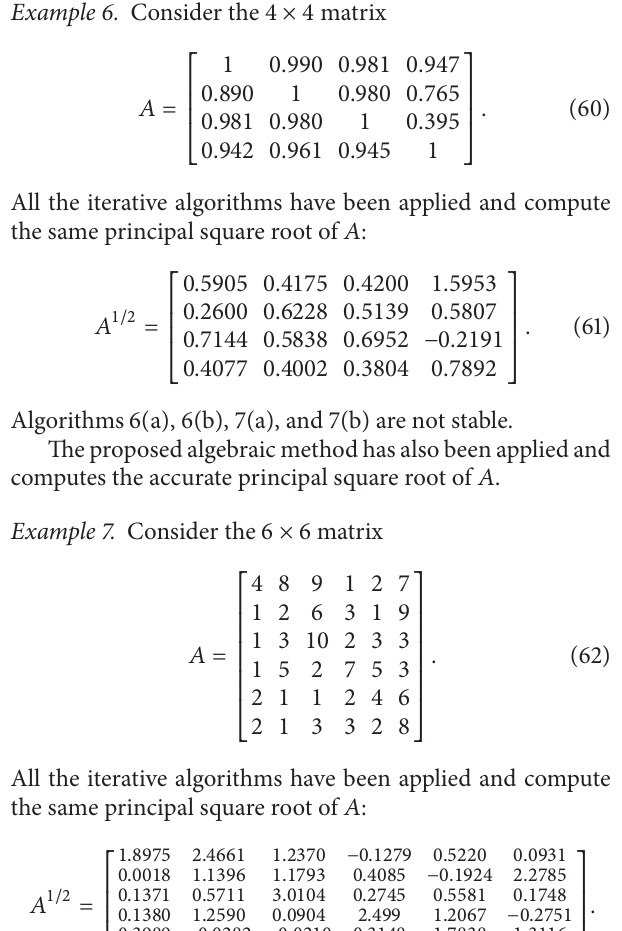
Algorithm 7(b) does not converge to the principal square